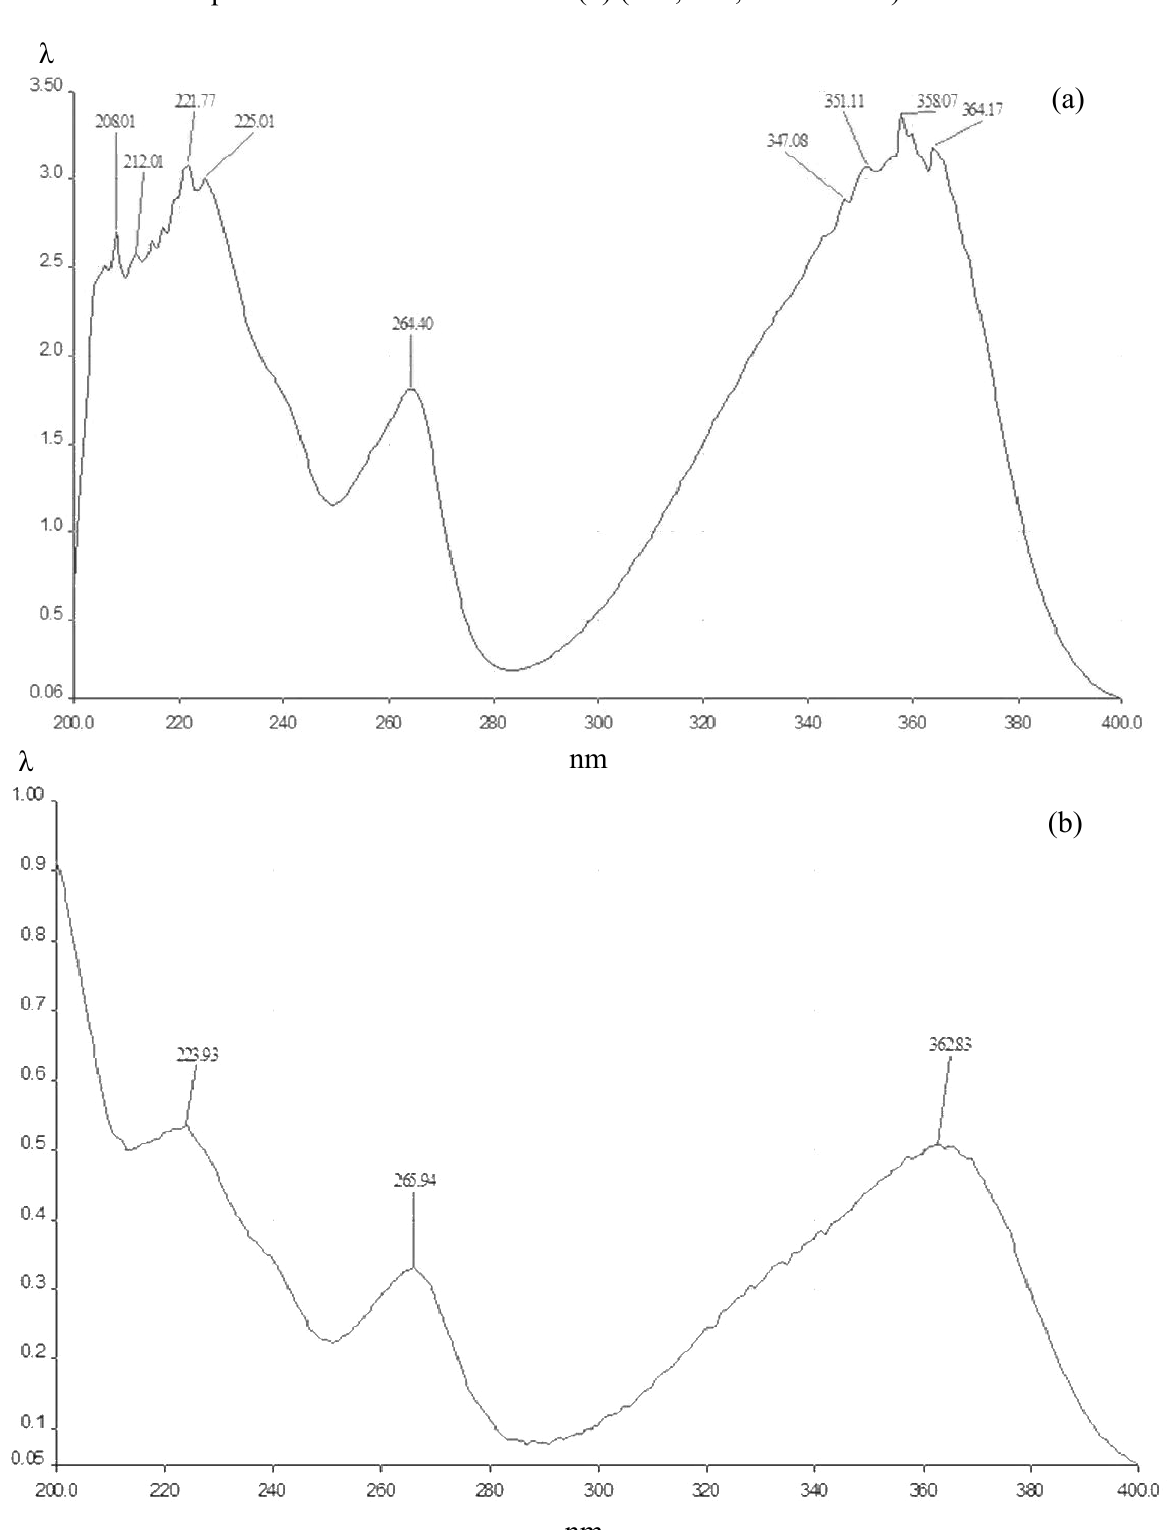
(AFB ) plus Man (a), and 1 1